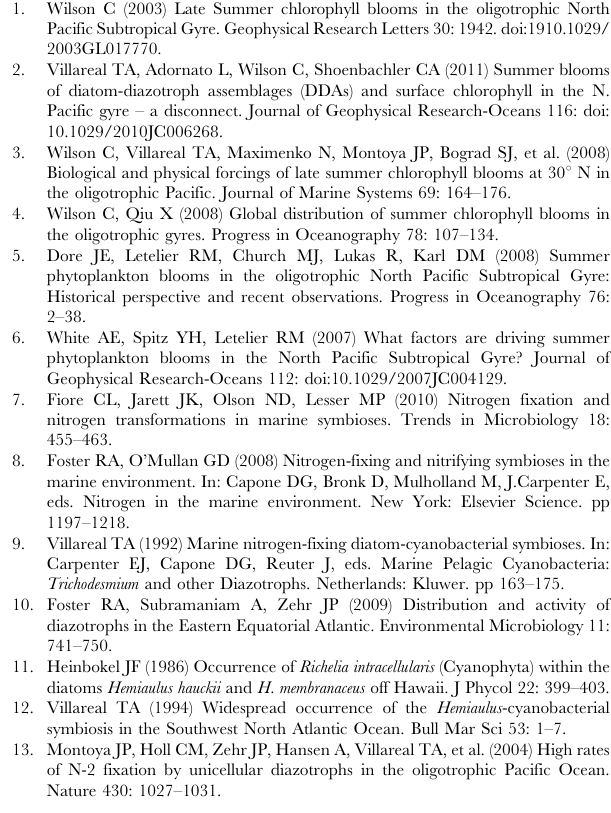
Figure S1 Transect 1, 2008: temperature, salinity, cell abundance, nutrients and chlorophyll a fluorescence. Stations are labeled above the figure. A. Temperature (˚C), B. Salinity (PSU). C. Silicate ( m M) D. Phosphate ( m M) E. Nitrate + Nitrite ( m M) F. R. intracellularis (filaments L 2 1 ) G. H. hauckii (cells L 2 1 ), H. M. woodiana and associated pennate diatoms (cells L 2 1 ), I. CTD chl a fluorescence ( m g L-1). J. Extracted chl a ( m g L 2 1 ), K. . 10 m m chl a ( m g L 2 1 ), L. % . 10 m m chl a , M. Biogenic silica total (nmol L 2 1 ). N. Cruise track with represented stations outlined in red. These figures are contoured data from the bloom transects identified in the Figure text. Figure S2 Transect 1, 2008 including the bloom Sta. 7. Stations are labeled above the figure. A. Temperature ( u C), B. Salinity (PSU). C. Silicate ( m M) D. Phosphate ( m M) E. Nitrate + Nitrite ( m M) F. R. intracellularis (filaments L 2 1 ) G. H. hauckii (cells L 2 1 ), H. M. woodiana and associated pennate diatoms (cells L 2 1 ), I. CTD chl a fluorescence ( m g L 2 1 ). J. Extracted chl a ( m L 2 1 ), K. . 10 m m chl a ( m g L 2 1 ), L. % . 10 m m chl a , M. Biogenic silica total (nmol L 2 1 ). N. Cruise track with represented stations outlined in red. Figure S3 Transect 2, 2008: Stations are labeled above the figure. A. H. hauckii (Cells L 2 1 , B. M. woodiana and associated